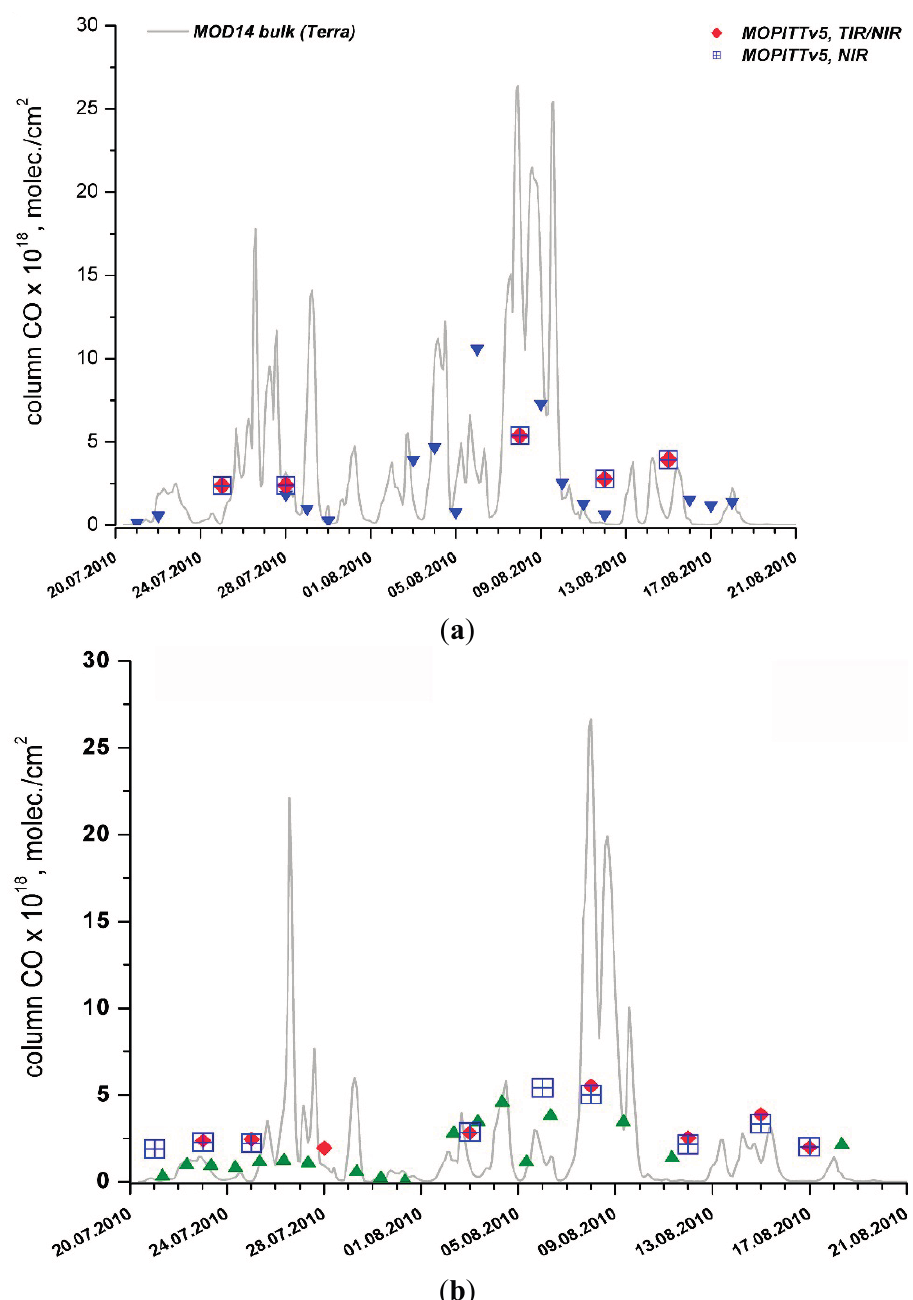
Figure 10. Experimental for OIAP ( a ) and ZSS ( b ) stations CO total columns and retrieval total column for MOPITTv5 NIR-only, MOPITTv5 TIR/NIR and MOPITTv4 satellite data have been shown. The model (RAMS/HYPACT) CO total column for MODIS/Terra hot spots has been shown as background for